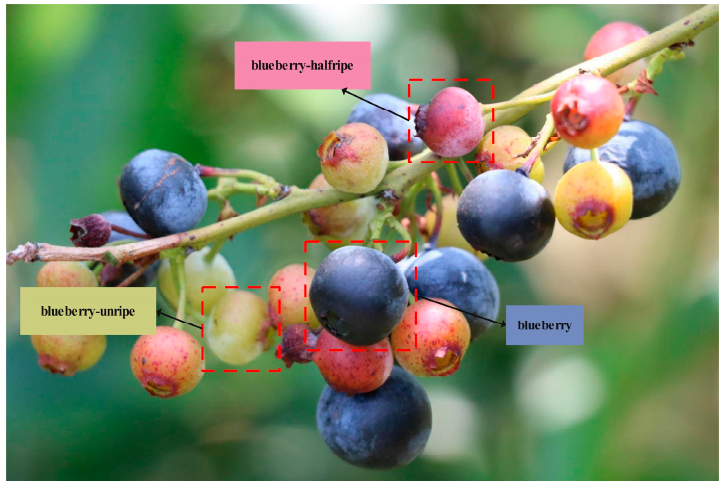
Figure 1. Blueberry ripeness comparison.